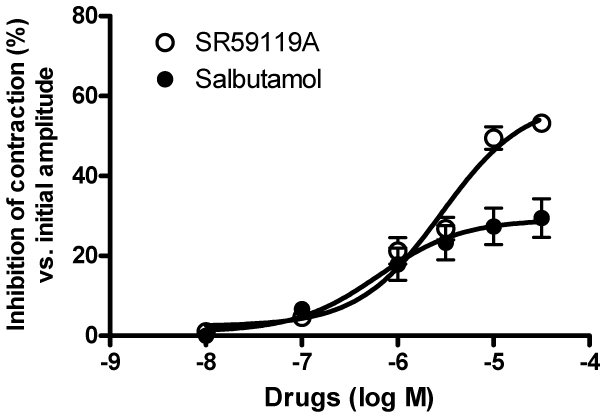
Concentration-response curve for SR59119 and Salbutamol (ADRB3 and ADRB2 agonists respectively) in human near term myometrium.